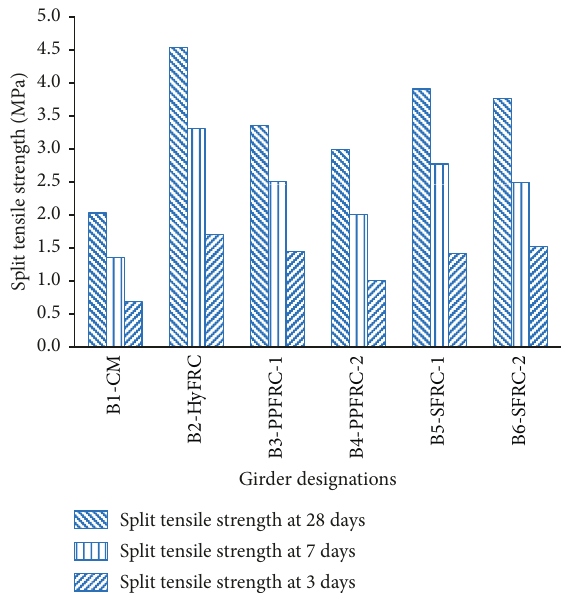
Figure 7: Average split tensile strength of all mixes at different curing